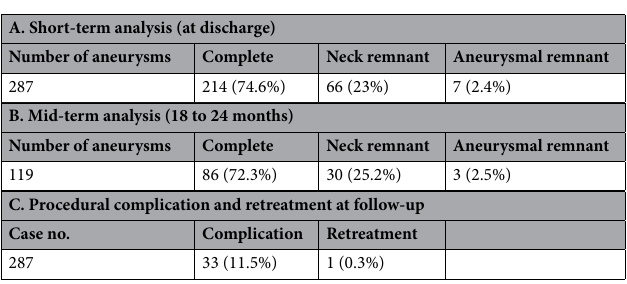
Table 6. Summary of microsurgical treatment for wide neck